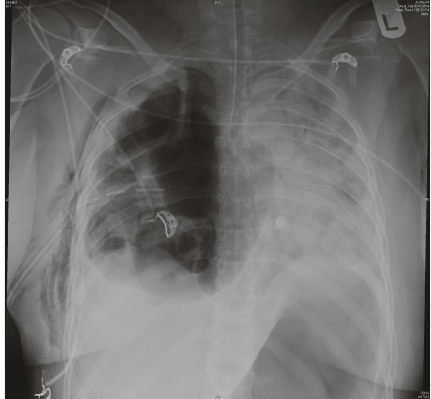
Figure 3: Chest X-ray showing multiple air-filled cavitary right lung lesions, right-sided pleural effusion, and progression of the air-space disease in the left lung.